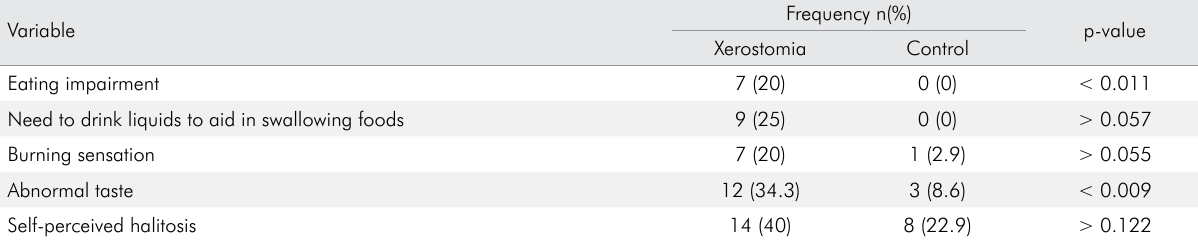
Table 3. Patient-reported symptoms.